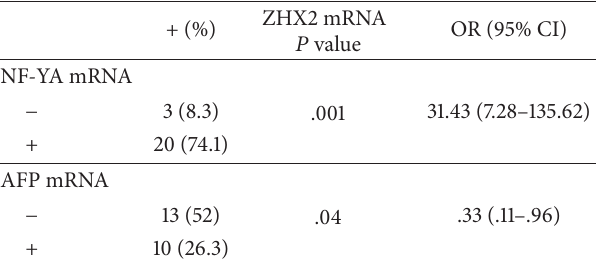
Table 5: Relationship between ZHX2, NF-YA, and AFP mRNA expressions in HCC tissues.